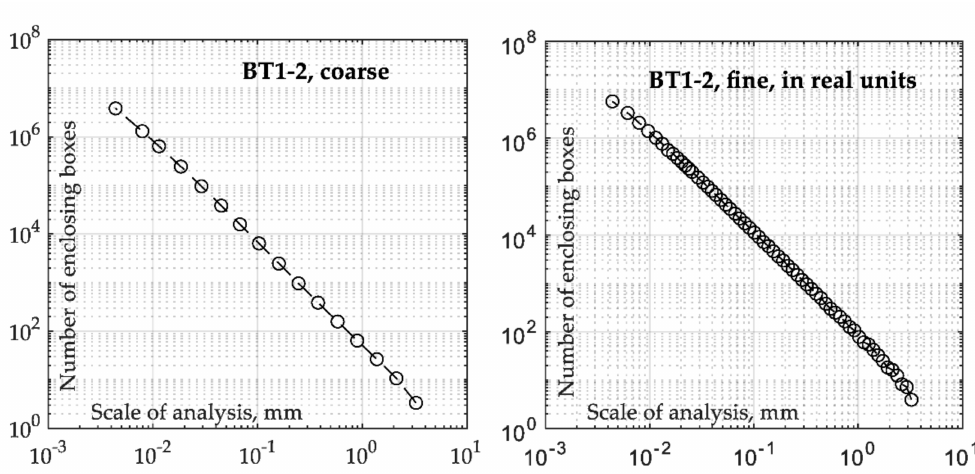
Figure 9. Fractal dimension Df data obtained using individual parameters for the BT1-2